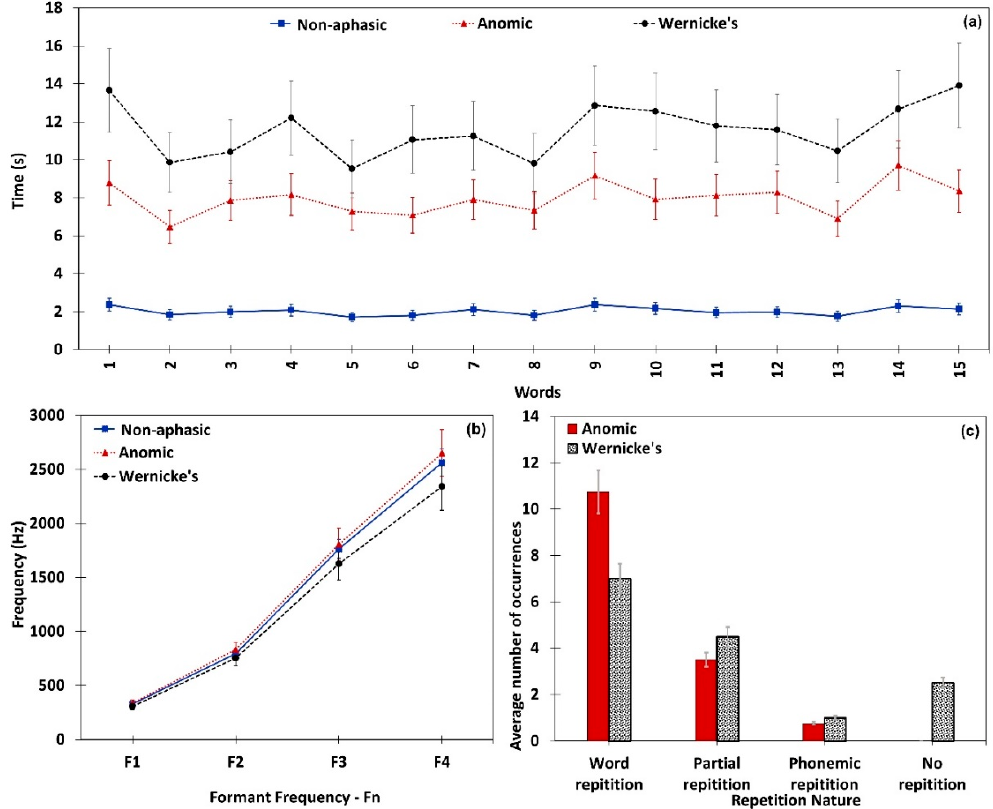
Figure 5. Repetition performance of the neurologically non-aphasic, Anomic, and Wernicke’s subjects.